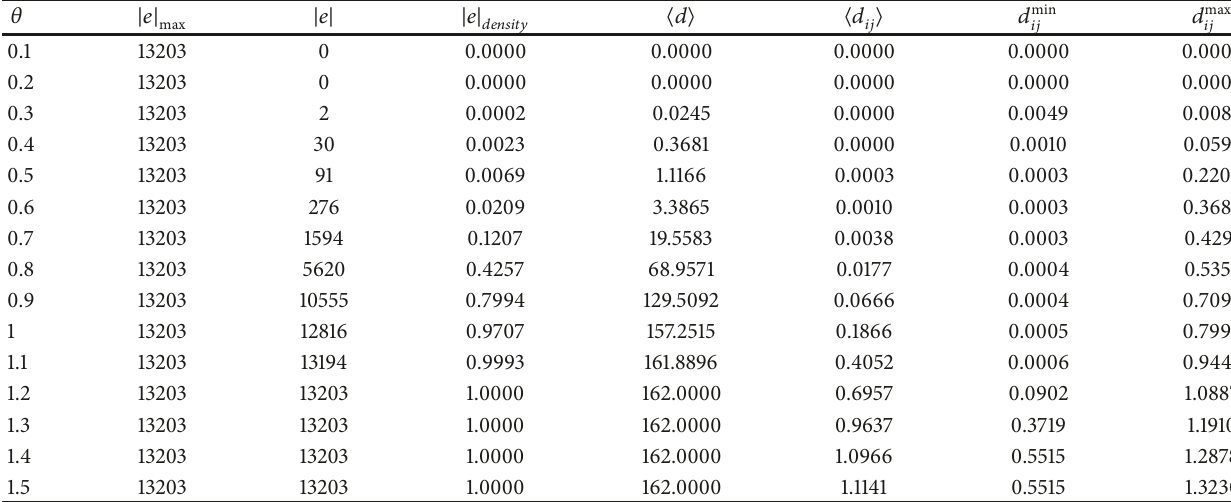
Table 4: For the CSI163 network, the maximum possible number of edges of |𝑒| max for 𝑁 = 163 vertices, the existing edge number |𝑒| , the edge density |𝑒| 𝑑𝑒𝑛𝑠𝑖𝑡𝑦 , the average degree ⟨𝑑⟩ , the average distance ⟨𝑑 𝑖𝑗 ⟩ , the minimum distance 𝑑 min 𝑖𝑗 , and the maximum distance 𝑑 max 𝑖𝑗 are presented for different 𝜃 from 0 to 1.5 in a step of